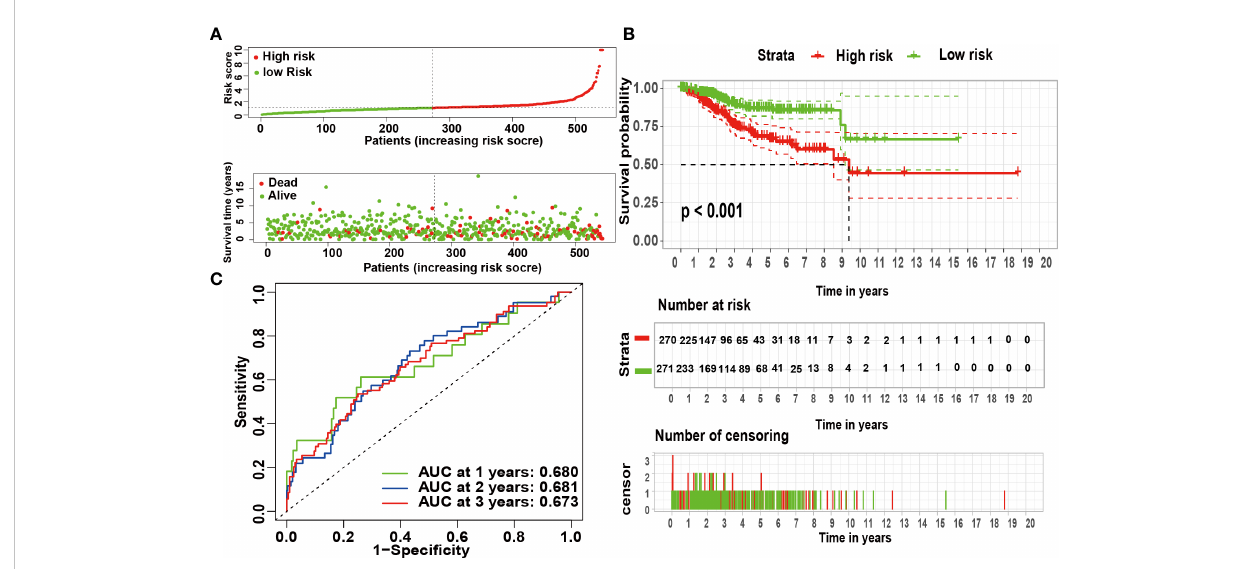
FIGURE 6 The risk coef fi cient model of UCEC predicted outcome. (A) The distribution of the risk scores of UCEC patients. (B) A Kaplan-Meier curve was constructed based on the survival status of the high- and low-risk groups. (C) The time-dependent curve showed that the AUC values at year 1, 2, and 3 were separated 0.680, 0.681, and 0.673, respectively.